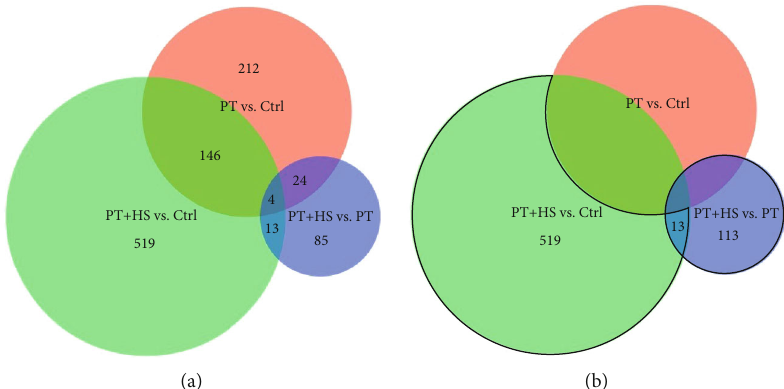
Figure 2: Venn diagram demonstrating the number of di ff erentially expressed genes after exclusion of genes without gene symbols in the comparisons between the three experimental groups (a). Genes included in the enrichment analysis are bordered in black (b). Signi fi cantly up- and downregulated genes in the class comparison between the groups PT+HS and PT (blue, 126 genes) were analyzed. Genes up- or downregulated in the group PT+HS (green) but not in the group PT (red), both times compared to the Ctrl group, were also included (532 genes). 13 genes were duplicates as they ful fi lled both the inclusion